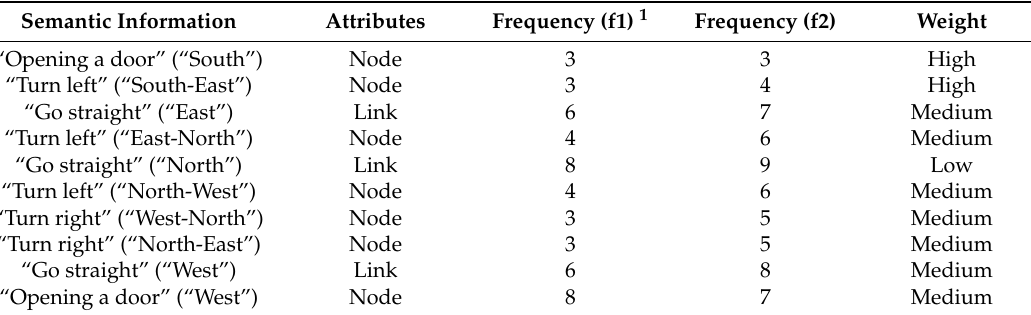
Table 1. Semantic weight in trajectory T e